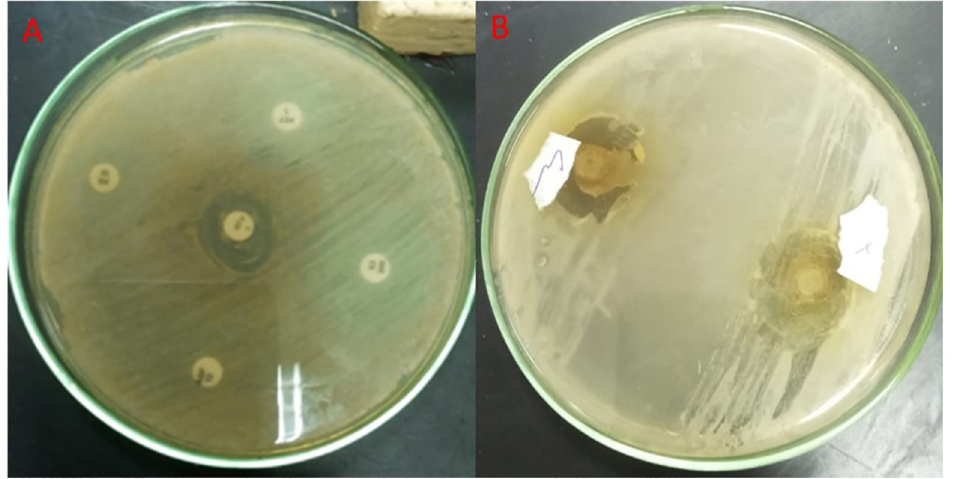
Fig 6. Selected disks show the disk diffusion (antibacterial) activity of silver nanoparticles. (A) Inhibition zone present around the disc dipped in AgNPs and (B) inhibition zone absent around the disc (control).